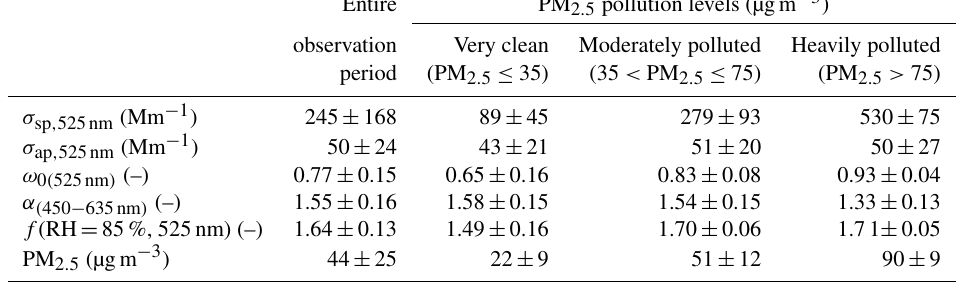
Table 1. Average σ sp , 525nm , σ ap , 525nm , ω 0 ( 525nm ) , α ( 450 − 635nm ) , f (RH = 85%, 525nm), and PM 2 . 5 mass concentration values at different pollution levels.